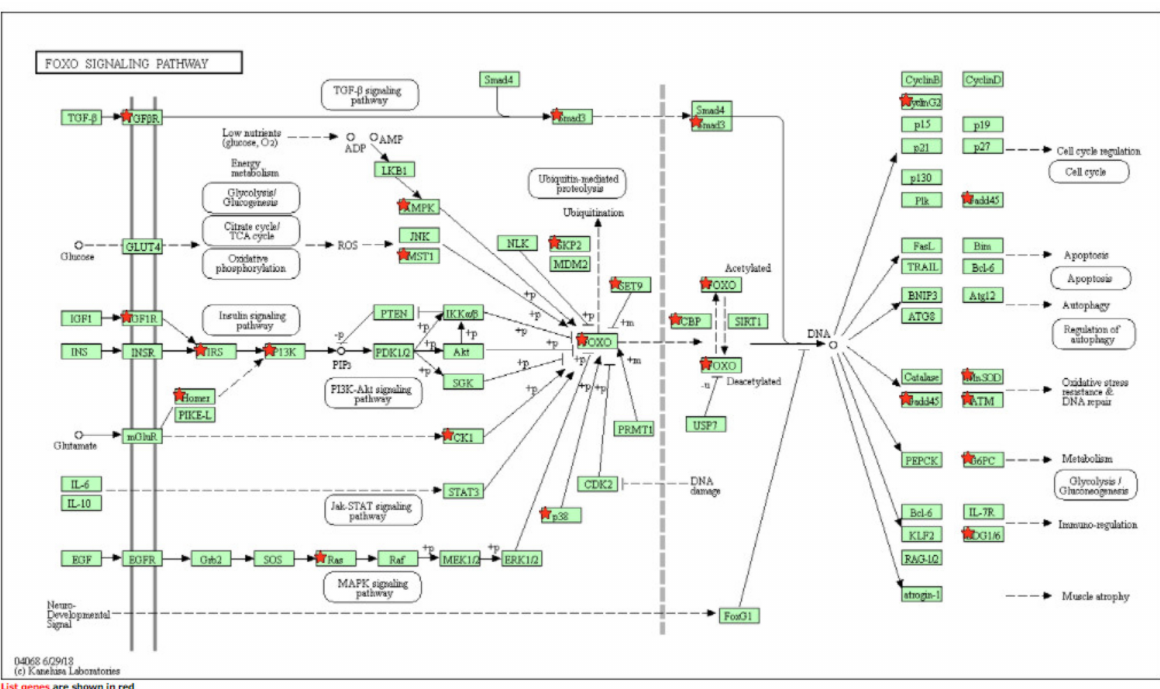
Figure 2. FoxO signaling